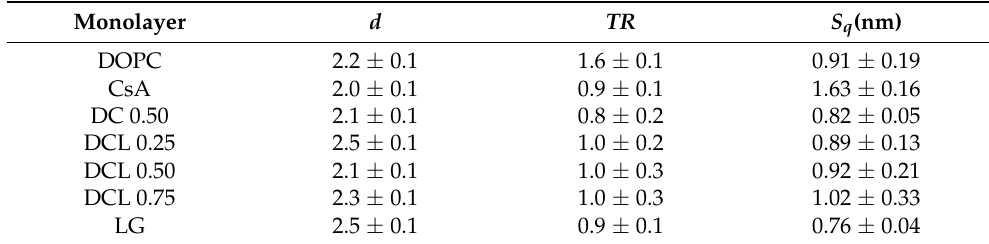
Table 1. Thickness ( d ) and transfer ratio ( TR ) values for the indicated monolayers obtained at the air/water interface as well as S q roughness parameter gained by means of AFM for the modified PET